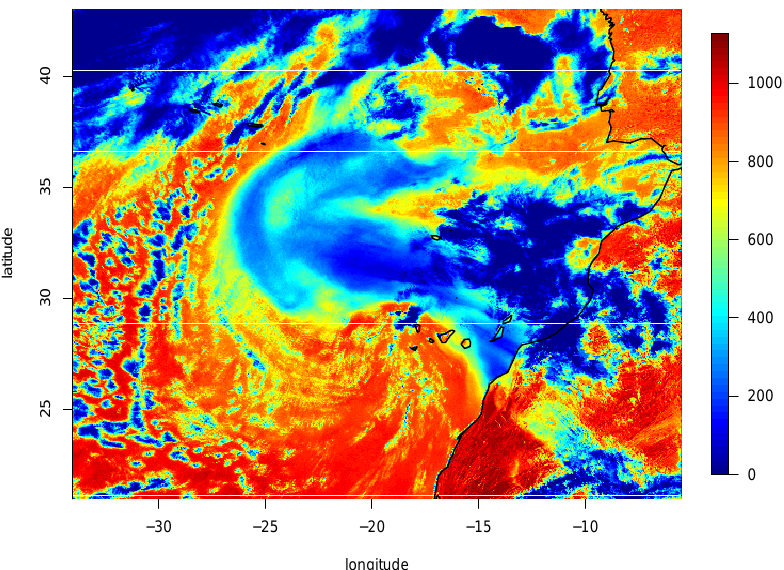
Figure 4. Example for the effect of high CAL values induced by aerosol events. The high CAL values induced by the dust storm (Figure 2) leads to a significant reduction of the direct normal irradiance relative to the surrounding area. Table 1. Comparison of CAL and AOD for the sites Tamanrasset (TAM) and Sede